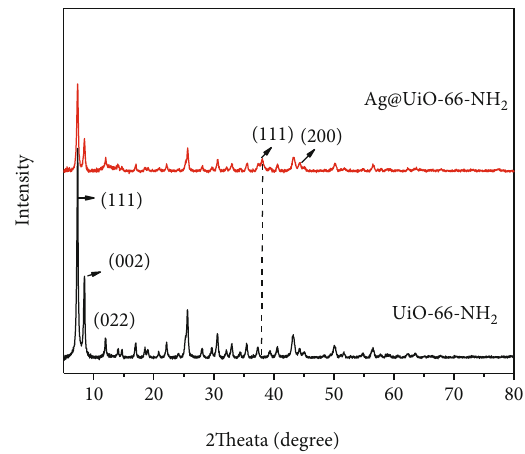
Figure 1: FTIR spectra of UiO-66-NH